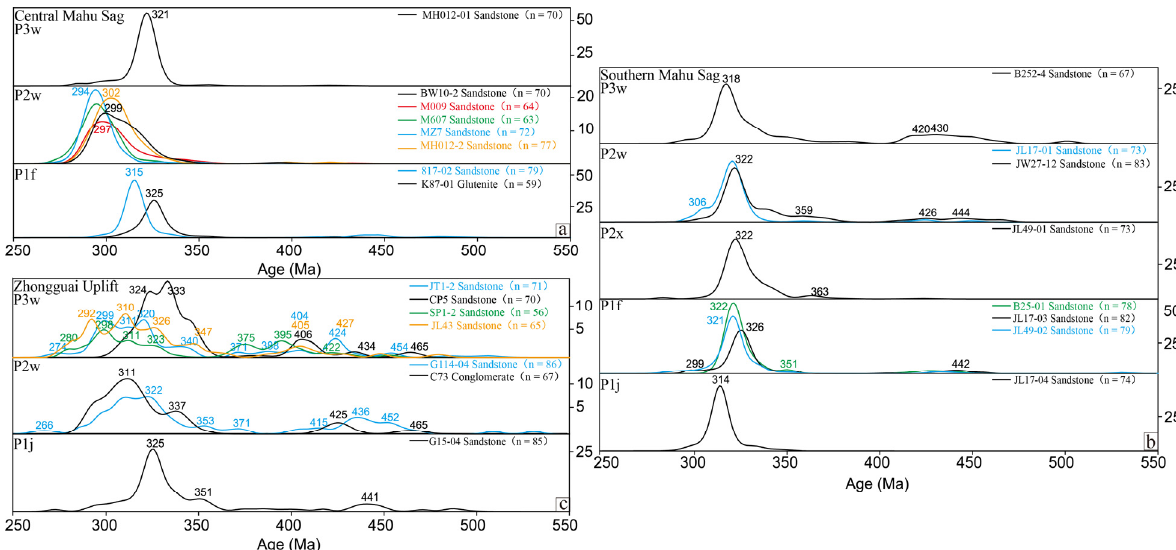
Figure 12. Distribution of the U-Pb ages of Permian detrital zircons over time. ( a ) The source-to-sink system CWJ → CMS in the central Mahu Sag (CMS). ( b ) The source-to-sink system CWJ + NWJ → SMS in the southern Mahu Sag (SMS). ( c ) The source-to-sink system CWJ + SWJ → ZU in the Zhongguai uplift (ZU). The strata become younger from bottom to top.